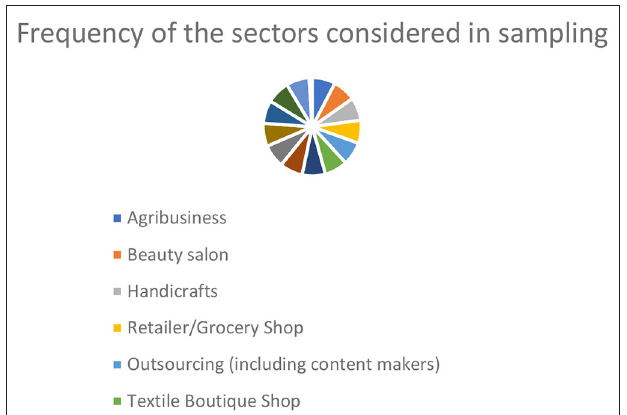
FIGURE 2 | Frequency of the sectors considered in